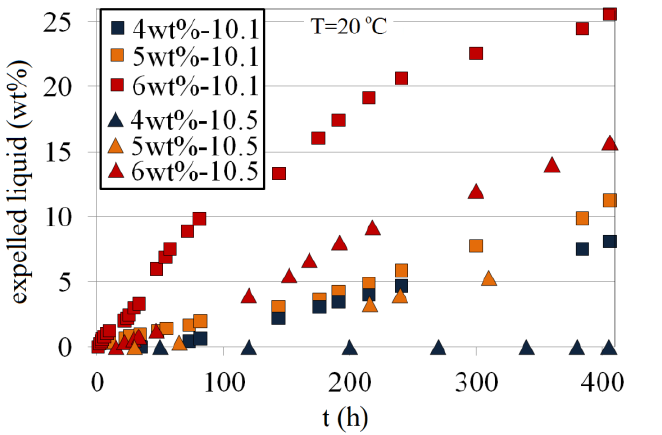
Figure 24. Weight percent of the expelled liquid as a function of time for 4 wt%, 5 wt% and 6 wt% Na-silicate solutions with pH values of 10.10 and 10.50 at 20 °C,